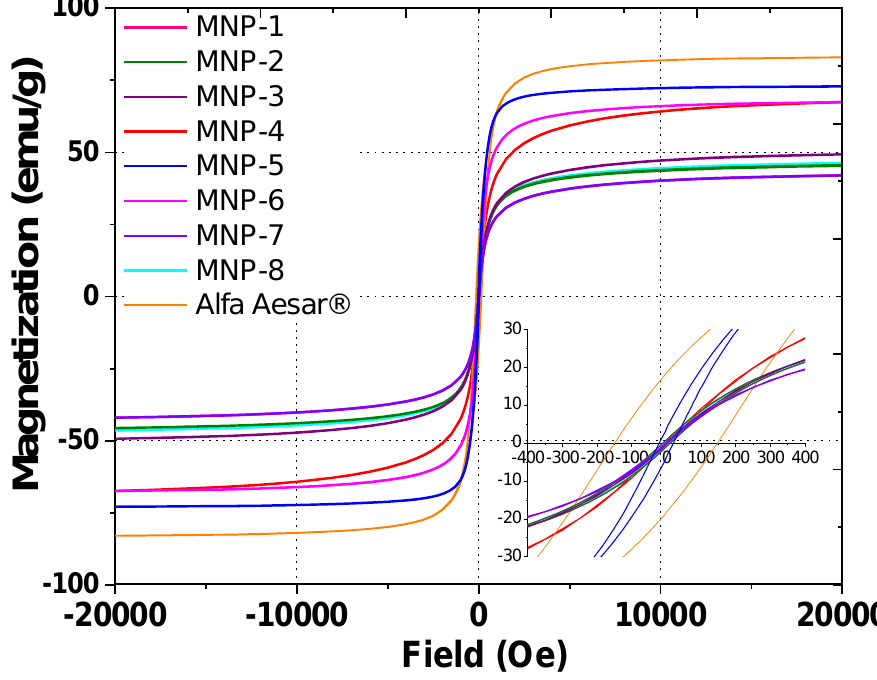
Figure 4. Wide and narrow (insert) magnetic hysteresis loops of biosynthesized MNPs at room tem- perature.